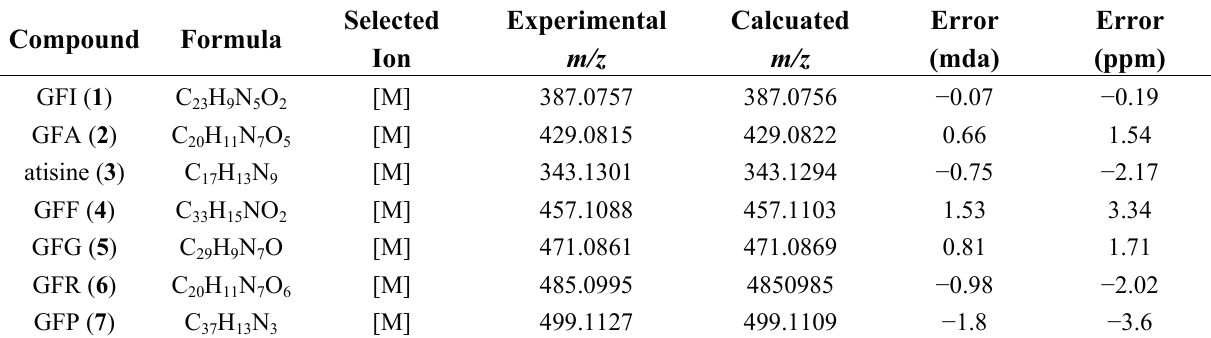
Table 3. Exact mass measurement and elemental composition of compounds from Aconitum coreanum